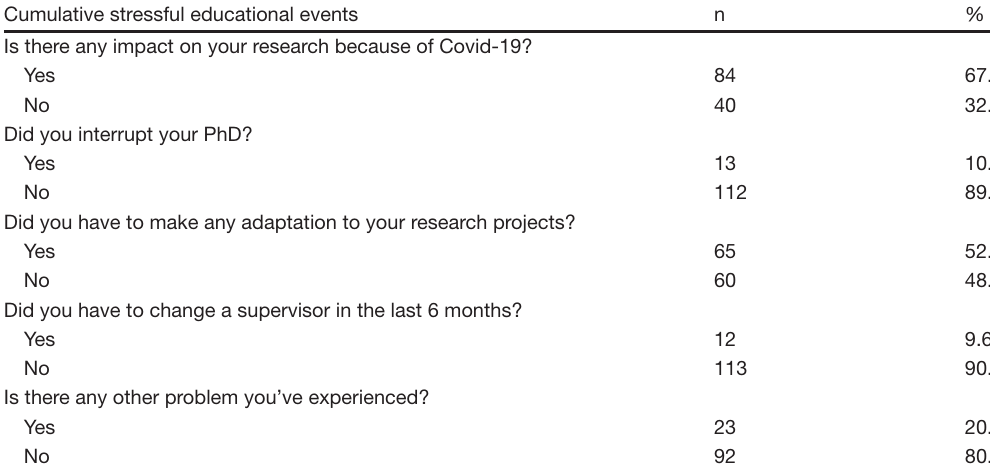
Table 2. Characteristics of the stressful educational events collected from the sample prior to summing up as a cumulative variable Cumulative stressful educational